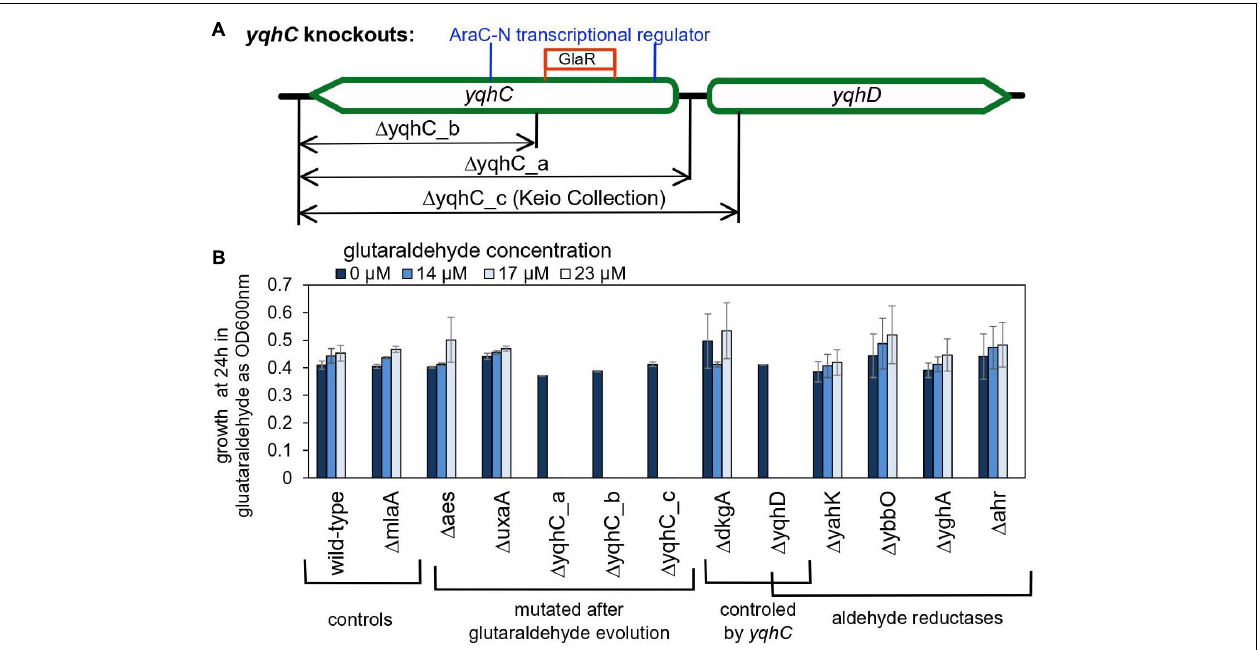
FIGURE 4 | The role of yqhC -regulated genes for the survival of Escherichia coli in the presence of various concentrations of glutaraldehyde. (A) Schematic illustration of the different knockout constructions for yqhC. The yqhC_c version represents the knockout strain obtained from the Keio Collection (Baba et al., 2006). (B) Growth of E. coli BW25115 wild-type and knockout mutants (measured as OD600 nm) at 24 h, in the presence of a range of glutaraldehyde concentrations. The genes aes , uxaA and yqhC were mutated in the glutaraldehyde-evolved strains, while yahK, ybbO, yghA and ahr are genes for other aldehyde reductases in E. coli besides yqhD . The mlaA gene was selected as a negative control to account for a potential effect of the kanamycin cassette over the growth results. Error bars represent standard error of duplicates.